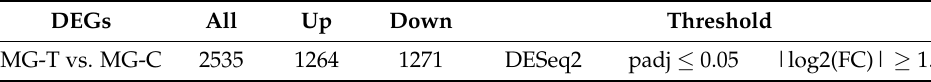
Table 2. Statistical analysis of differentially expressed genes.